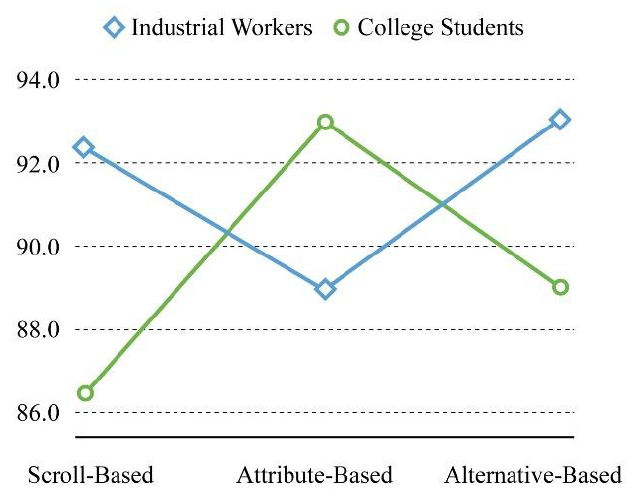
Figure 5. The interaction diagram regarding total SUS score.